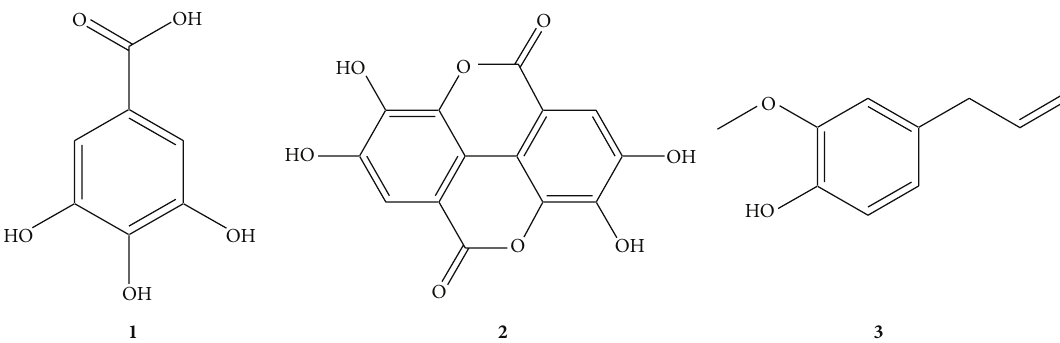
Figure 1: Chemical structures of three standard compounds in Syzygium aromaticum extract: ( 1 ) gallic acid, ( 2 ) ellagic acid, and ( 3 )